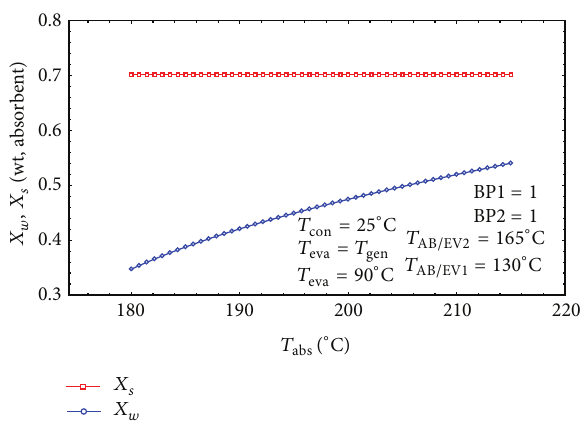
Figure 11: The effect of 𝑇 weak solution.